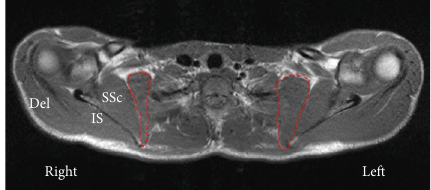
Figure 2: T 1 -weighted magnetic resonance image showing slight atrophy of the serratus anterior muscle (dotted line) on the right side compared with left side in the axial plane. SSc: subscapularis muscle; IS: infraspinatus muscle; Del: Deltoid